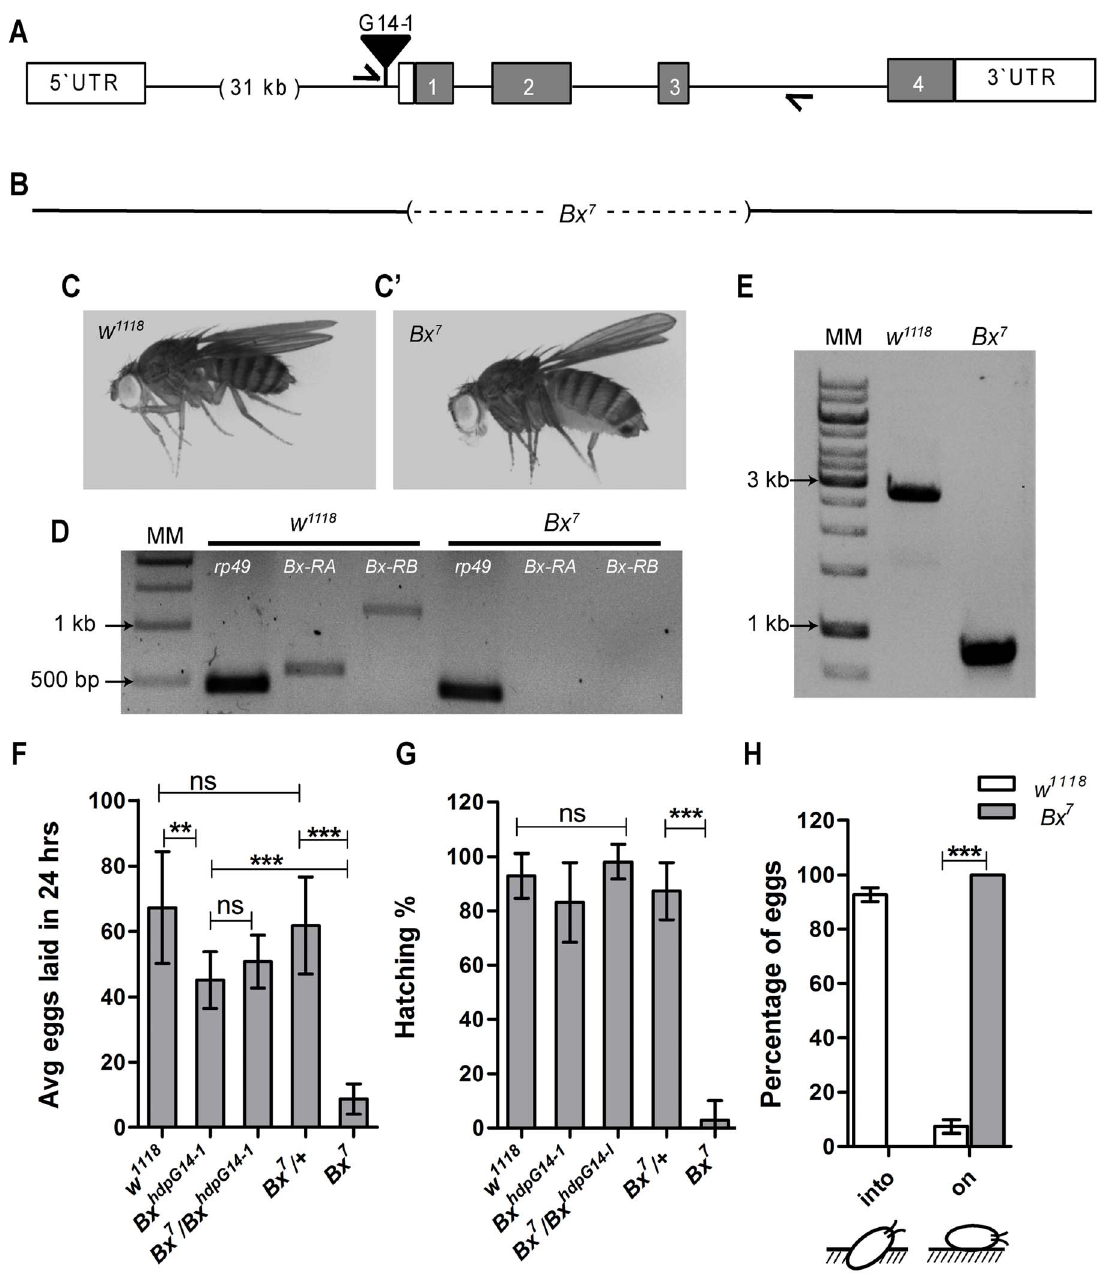
Figure 1. Bx null females show compromised reproduction. Bx null allele was generated for assessing their reproductive ability. (A) Genomic location of G14-1 P[GawB] element which was mobilized using D 2–3 transposase. (C, C’) Bx null flies ( Bx 7 ) generated showed held-up wings. (D) RT- PCR analysis showed complete absence of Bx -RA and Bx -RB transcript products. (E) PCR amplification of genomic DNA of Bx 7 flies showed deletion of , 2 kb from Bx gene sequence. Position of primers used for the genomic PCR is depicted in A and genomic region deleted in Bx 7 is represented in B. (E) Bx 7 females have highly reduced fecundity (F, ***, p , 0.0001; **, p=0.0011) and fertility (G, ***, p , 0.0001) (no of eggs tested . 800 ( w 1118 and controls), , 200 ( Bx 7 )) (Students unpaired t-test with Welch’s correction) compared to wild type and other controls. (H) almost 100% of the eggs are laid on the surface of the media by Bx 7 mutant females compared to control females which deposit upto 90% of the eggs into the media (schematic of eggs laid by control and Bx 7 mutant females is shown below the X-axis of the graph) (***, p , 0.001, Two way anova with Bonferroni post